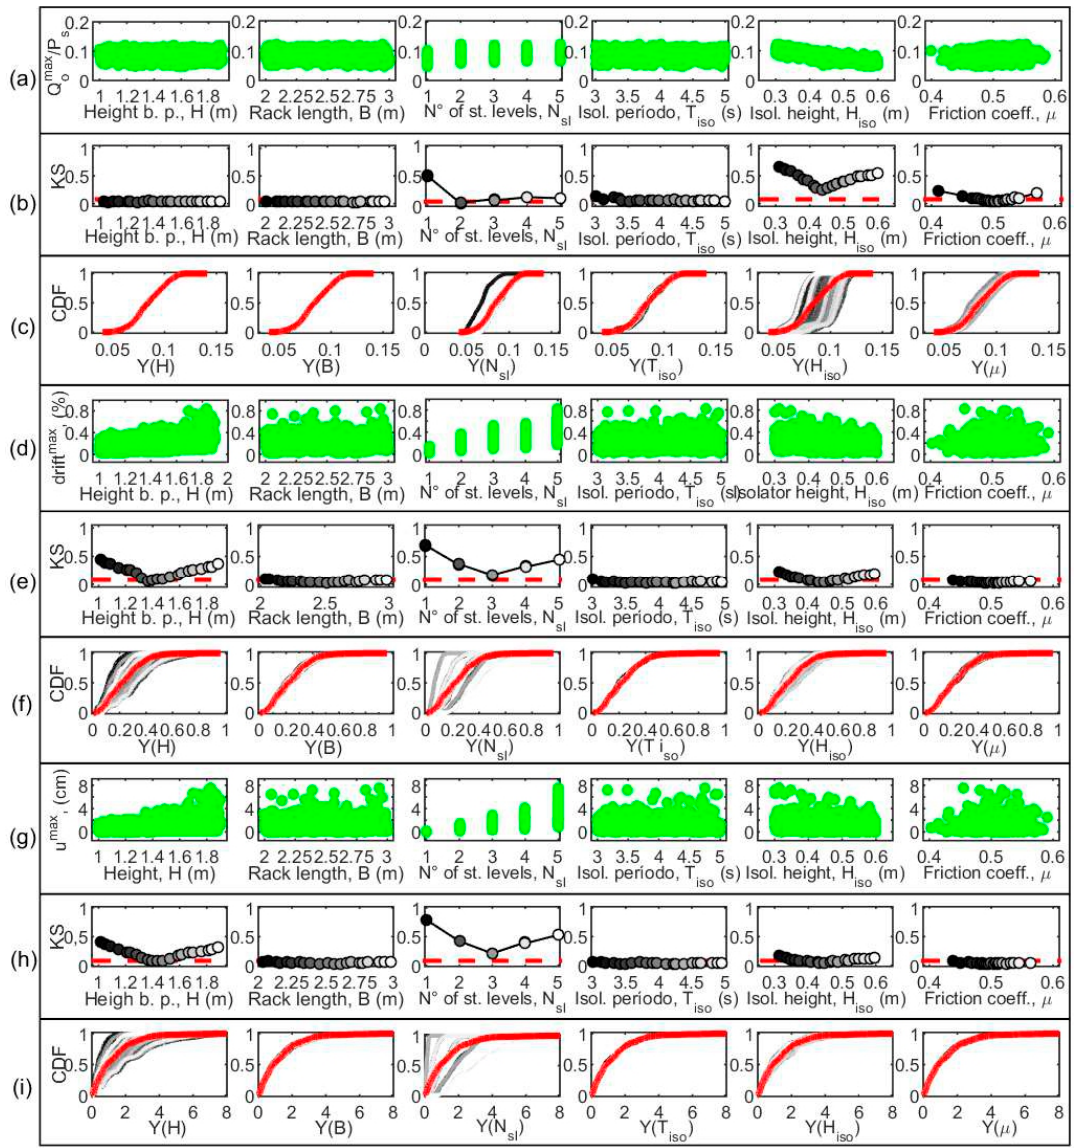
Figure 7. Scatterplot, Kolmogorov-Smirnov Statistics (KS) and conditional and unconditional CDFs of the target responses. Rows ( a – c ) are the maximum base shear load ( Q max o ) normalized by the seismic weight ( P s ); ( d – f ) are maximum drift and ( g – i ) are maximum displacement ( u max ) of